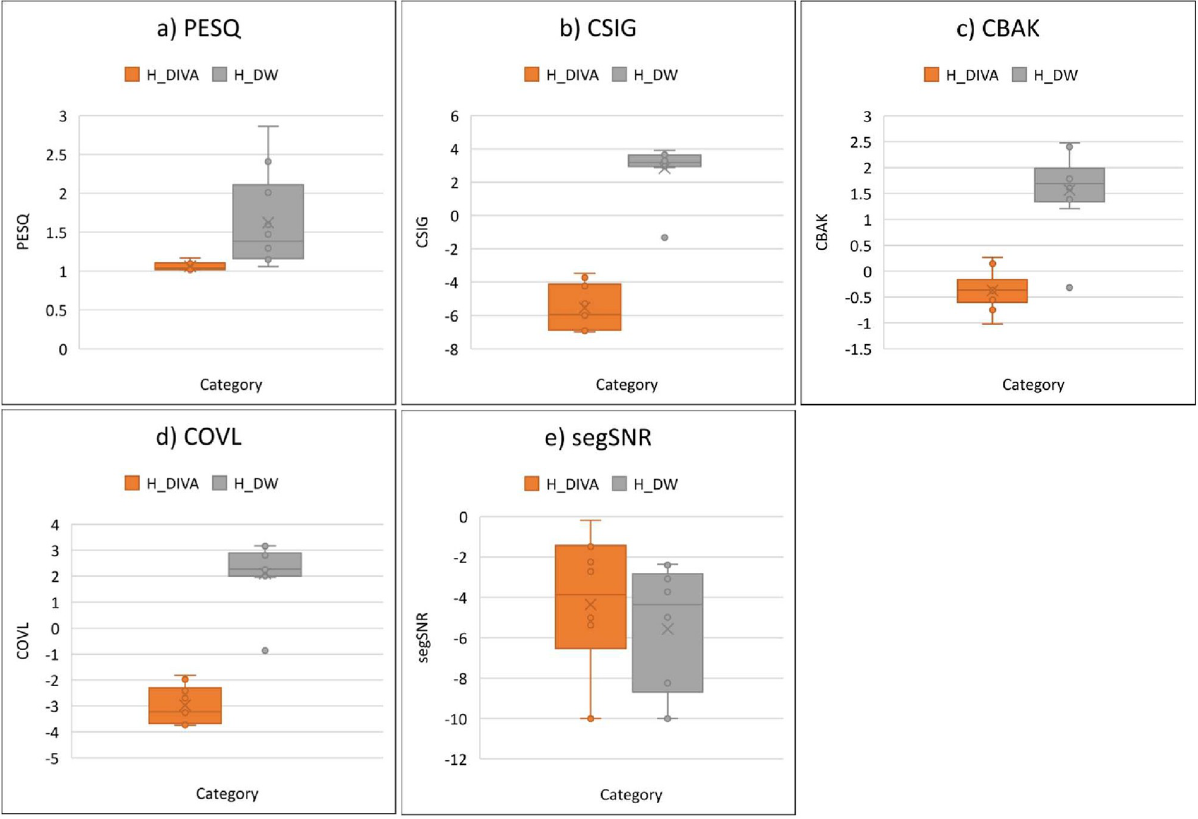
Fig 7. TorchDIVA and DiffWave speech quality metrics. Speech quality metric comparison between TorchDIVA and DiffWave-enhanced TorchDIVA samples. Original human speech sample is reference signal for all metric calculation. H_DIVA: human reference vs. TorchDIVA output. H_DW: human reference vs. DiffWave-enhanced output. a) Perceptual evaluation of speech quality (PESQ). b) Predicted rating of speech distortion (CSIG). c) Predicted rating of background distortion (CBAK). d) Predicted rating of overall quality (COVL). e) Segmental signal-to-noise ratio (segSNR).